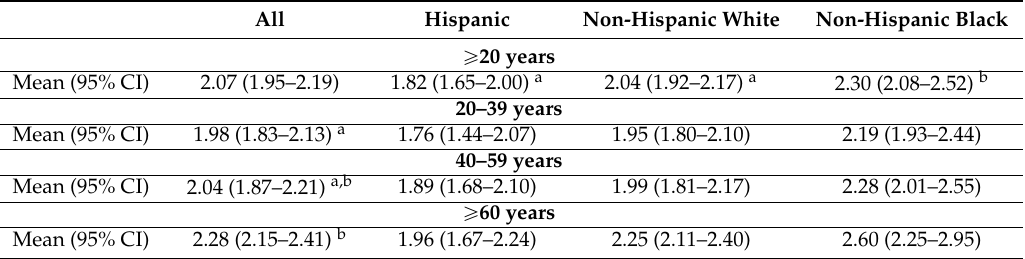
Table 2. Mean long chain n -3 PUFA status (% of total fatty acids: EPA + DPA + DHA) in all participants and by race and age.